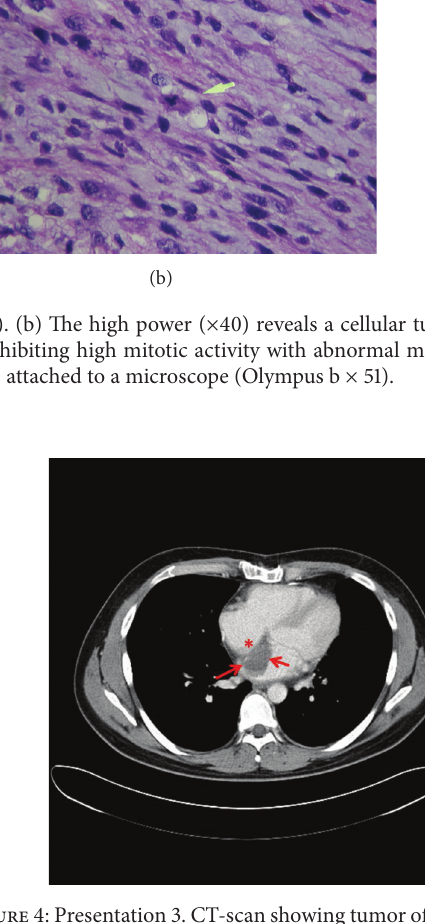
Figure 4: Presentation 3. CT-scan showing tumor of the intra-atrial septum in the left atrium, nongated